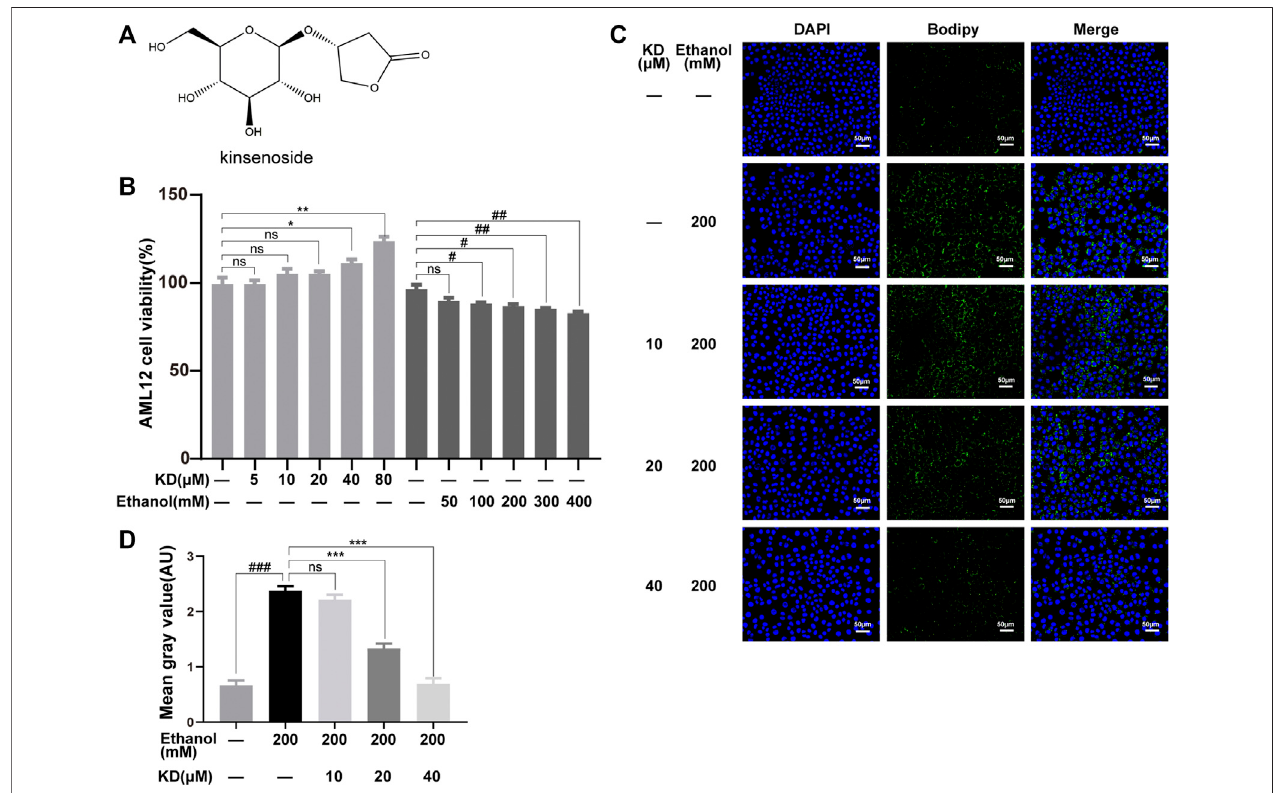
FIGURE1| EffectsofKDoncellularethanol-inducedlipidaccumulation. (A) ThechemicalstructureofKD. (B) EffectsofKDandethanolonAML12cellviability( n (cid:1) 4). (C) Images of BODIPY-stained AML12 cells treated with KD and/or ethanol for 48 h. Scale bar: 50 µm. (D) Quantitative analysis of BODIPY staining ( n (cid:1) 3). Data representthemean ± SEM.ns, notsigni fi cant,* p < 0.05,** p < 0.01, *** p < 0.001,KD-treated vs.untreated cells. # p < 0.05, ## p < 0.01, ### p < 0.001,alcohol-treatedvs. untreated